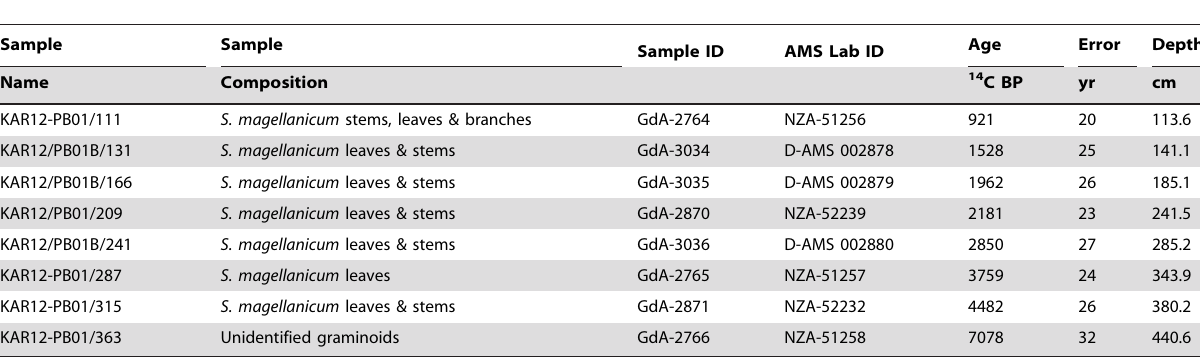
Table 1. Results of the AMS radiocarbon dating of 8 selected samples from